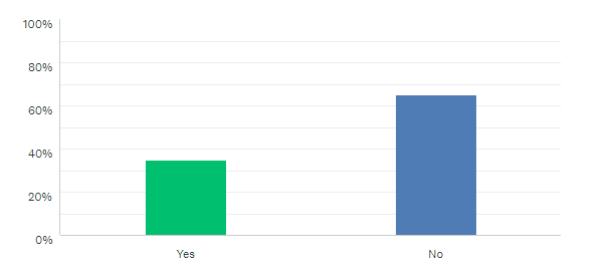
Figure 5. Respondent’s knowledge on counselling facilities